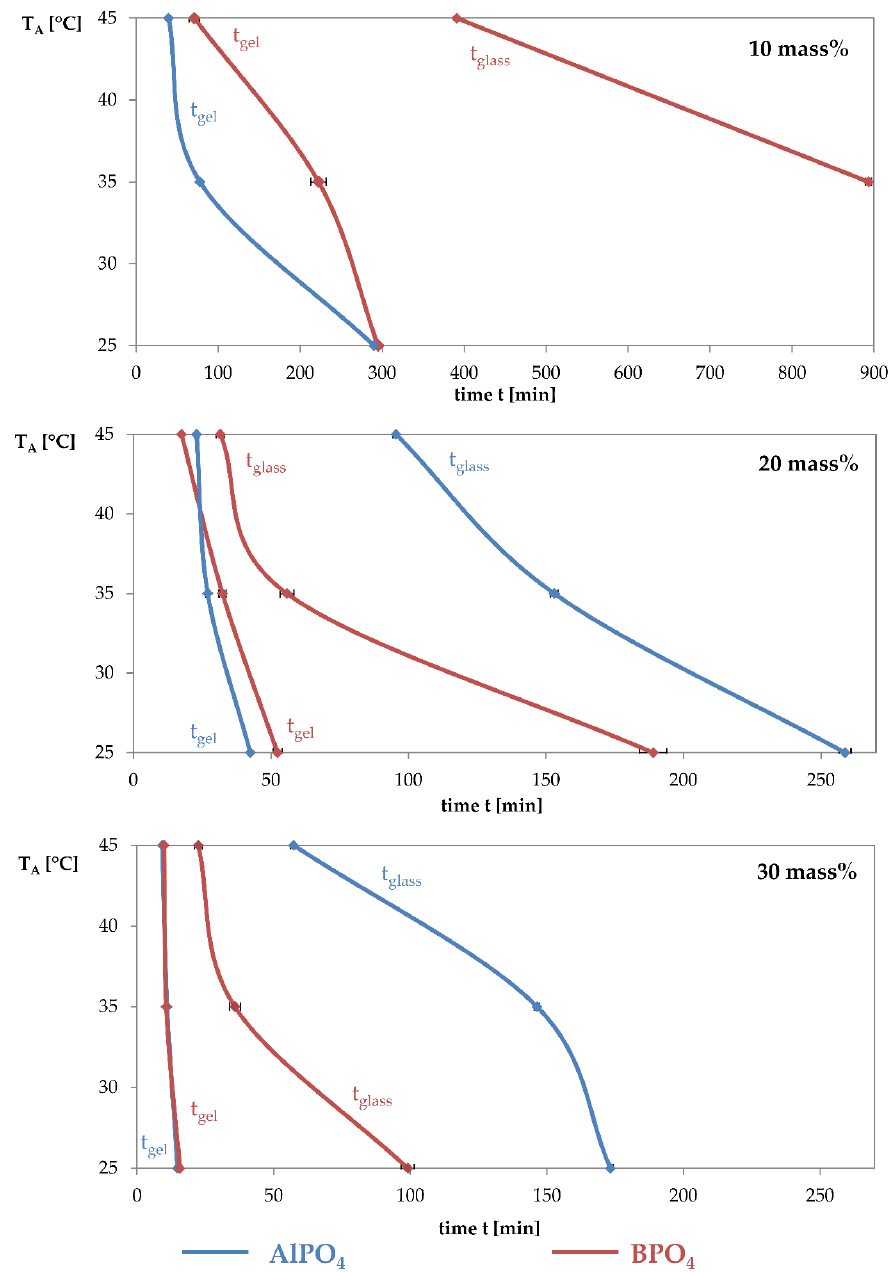
Figure 3. Time–temperature–transformation diagrams of the phosphate–waterglass mixes.